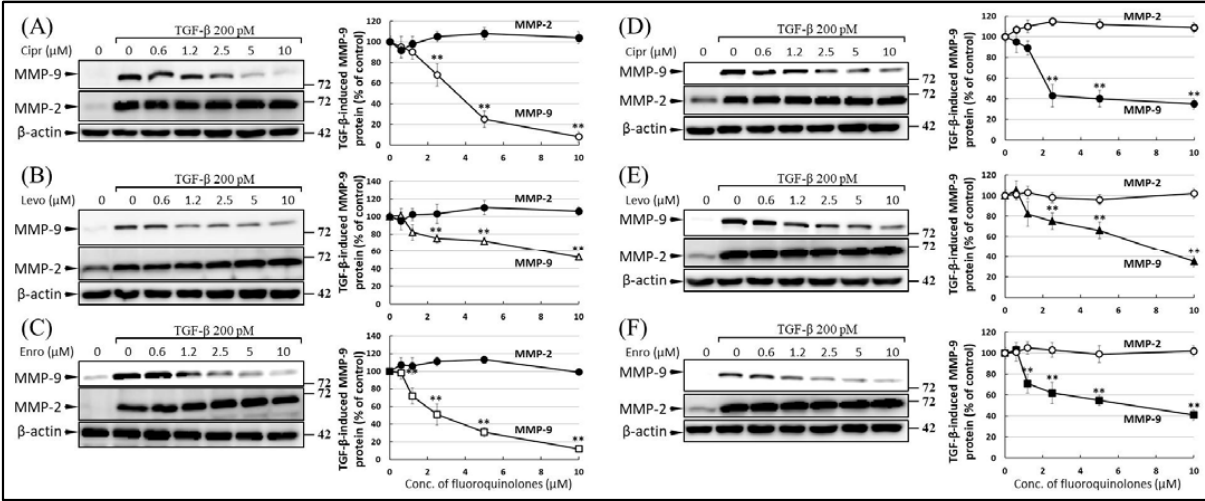
Figure 3. Fluoroquinolones (FQs) inhibit transforming growth factor beta (TGF- β )-induced matrix metalloproteinase-9 (MMP-9) expression in A549 ( A – C ) and HepG2 ( D – F ) cells. Cells were pre-treated with increasing concentrations of ciprofloxacin ( A , D ), levofloxacin ( B , E ), and enrofloxacin ( C , F ) for 1 h, followed by stimulation with TGF- β for another 48 h; the protein levels in the conditional medium were determined by Western blotting. The upper and lower bands represent MMP-9 (85 kDa) and MMP-2 (70 kDa), respectively. Images shown in ( A – F) are representative of three independent experiments with similar results. The MMP-9 and MMP-2 levels in the right graphs indicated treatment groups were normalized by β -actin and were expressed as a percentage of those in the TGF- β -stimulated control. The differences between treatment groups were considered significant at p ≤ 0.01 (**; right-hand graphs).